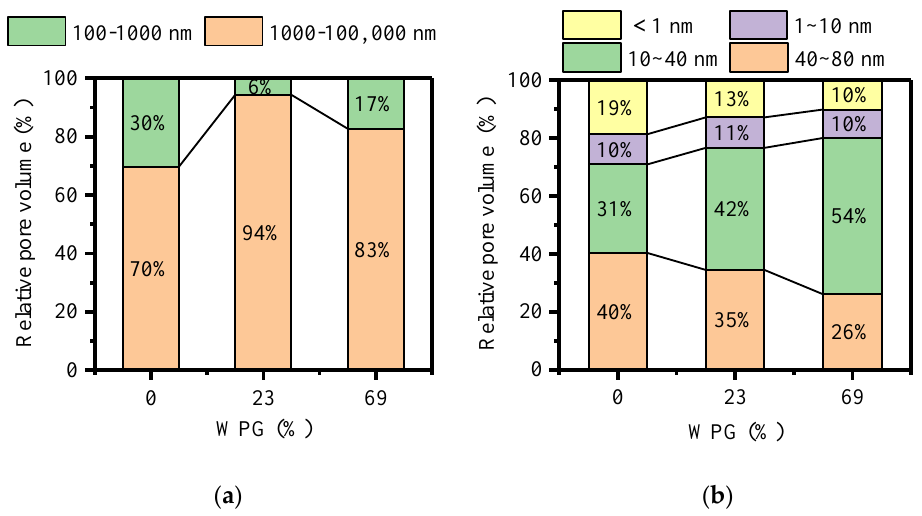
6 of 9 Figure 3. Pore volume versus pore size diameter in modified wood with different weight gain percent (WPG) (0%, 23% and 69%). 3.4. Component of Hierarchical Pores In order to further quantitatively explain the alteration of pore size of furfurylated wood, the relative pore volume was calculated by the percentage of pore volume (Figure 4). Compared with untreated wood, the relative pore volume for two furfurylated woods with pore diameters between 1000 and 100,000 nm dramatically increased and between